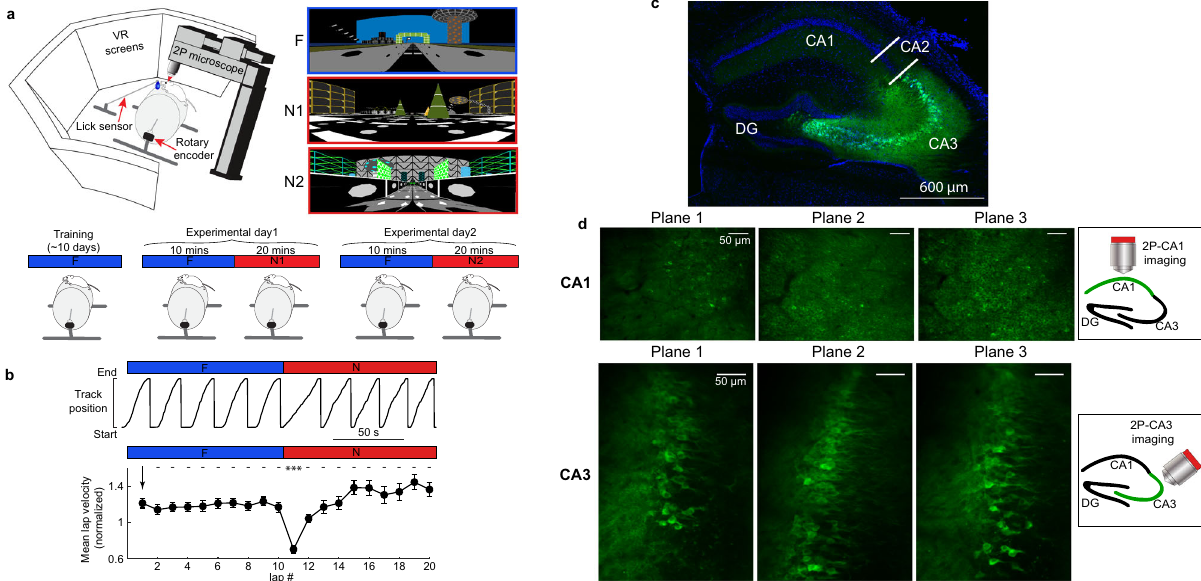
Fig. 1 Experimental setup. a Top left, depiction of the virtual reality (VR) setup. Top right, the familiar (F) and two novel (N1 and N2) environments. Bottom: scheme of the experimental procedure. b Top: single mouse behavior showing track position versus time during an F to N switch. Bottom: summary data across all mice of mean lap velocity during F and N ( n = 20 sessions in 11 mice). Lap velocity is normalized to the mean lap velocity in each mouse ±SEM, and each lap is compared to the fi rst lap in F using a one-way ANOVA with Tukey HSD post hoc test. *** P < 0.001, P = 6.3 × 10 − 15 . c Brain slice showing speci fi c CA3 expression of cre-dependent GCaMP6f (green) and DAPI for nuclei (blue) from a Grik4-cre transgenic mouse. d Example fi eld of views (FOV) from multiplane imaging in CA1 (top) and CA3 (bottom). Right: scheme of the position for the objective during